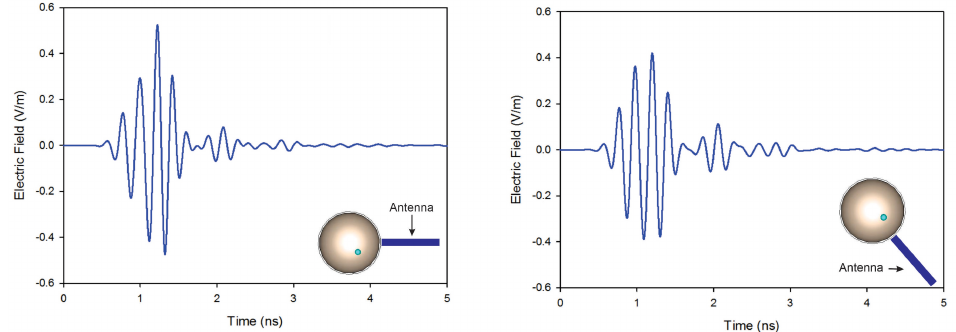
Figure 12. Back-scattered responses at two antenna positions using the proposed